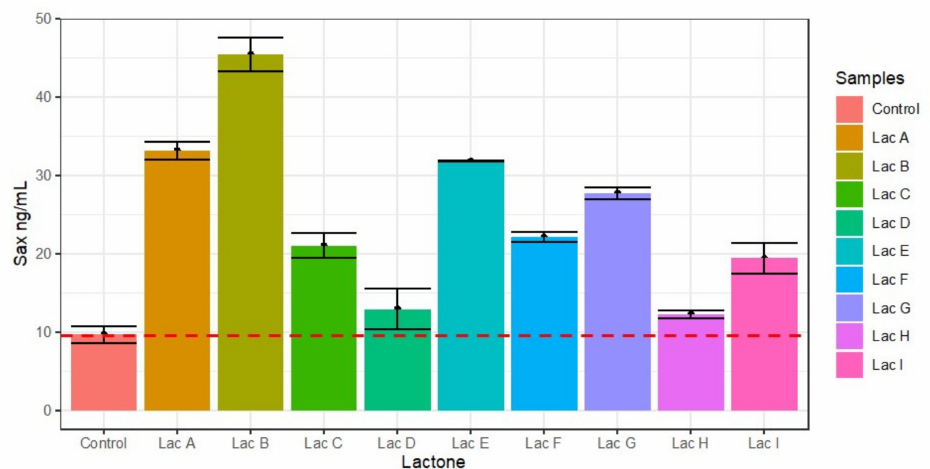
Figure 9. Effect of lactones on the production of saxitoxin. 3-oxodecanoyl ( A ), N-(3-oxododecanoyl)- L-homoserine lactone ( B ), N-hexanoyl ( C ), decanoyl ( D ), heptanoyl ( E )), N-dodecanoyl ( F ), N- octanoyl ( G ), N-(3- oxo-octanoyl ( H ), and N-butyryl-homoserine lactone (I). Lactones A, B, E, and G induced saxitoxin synthesis above 275% to almost 450% to the control, while lactones D and H were virtually inactive.